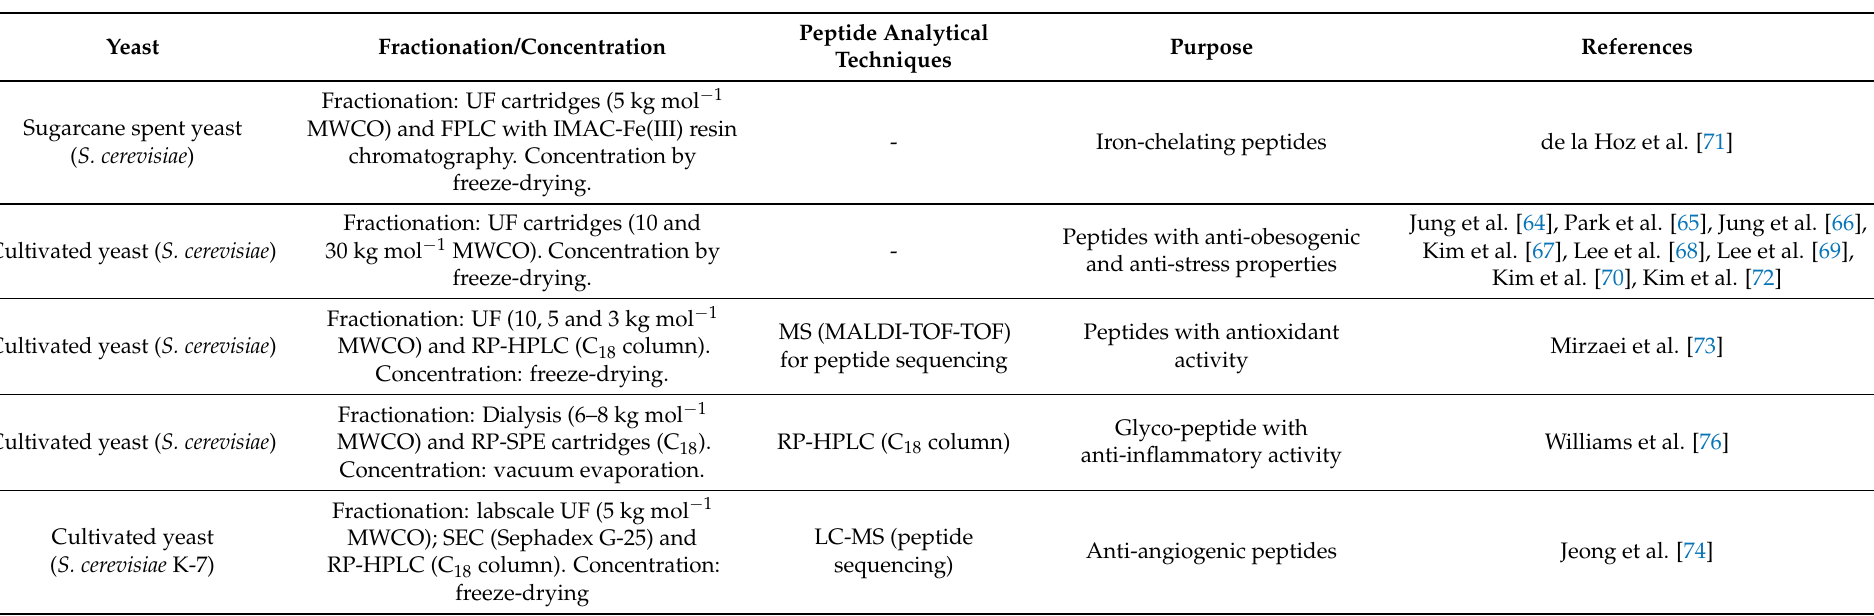
Table 2. Fractionation of yeast ( Saccharomyces sp.) protein hydrolysates by membrane technologies and/or chromatography in the production of bioactive